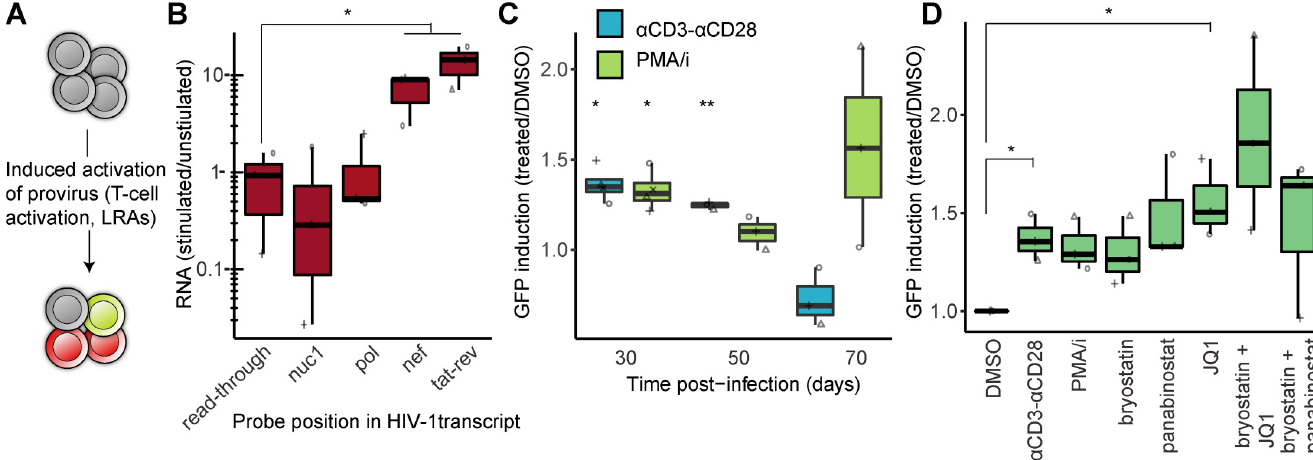
Fig 4. HIV-1 latency reversal by T-cell activation and LRAs. ( A ) Resting cells were treated with α CD3-CD28, PMA/i, or LRAs. ( B ) RT-ddPCR results at 4 proviral loci and the splice product tat-rev in activated/resting cells. ( C ) GFP-positive cells gated in flow cytometry at 30, 50 and 70 dpi after 48h treatment with DMSO, α CD3-CD28, or PMA/i. P-values are calculated between treated ( α CD3-CD28 or PMA/i) and mock-treated (DMSO) at each time-point. ( D ) GFP-positive cells gated in flow cytometry at 50 dpi after 48h treatment with LRAs. � p < 0.05, �� p < 0.01 (below the x-axis), calculated by paired t-test in panels (B–D).